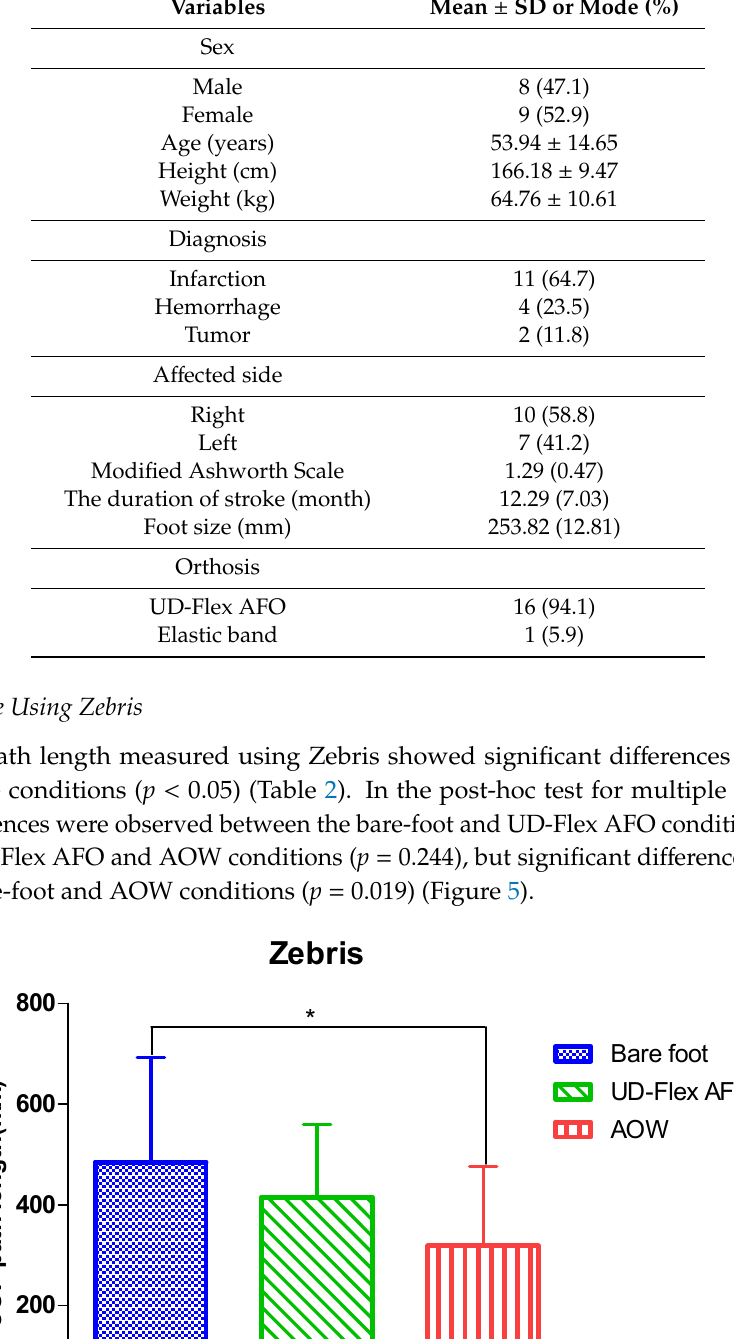
Table 3. Static balance using BioRescue. Variables